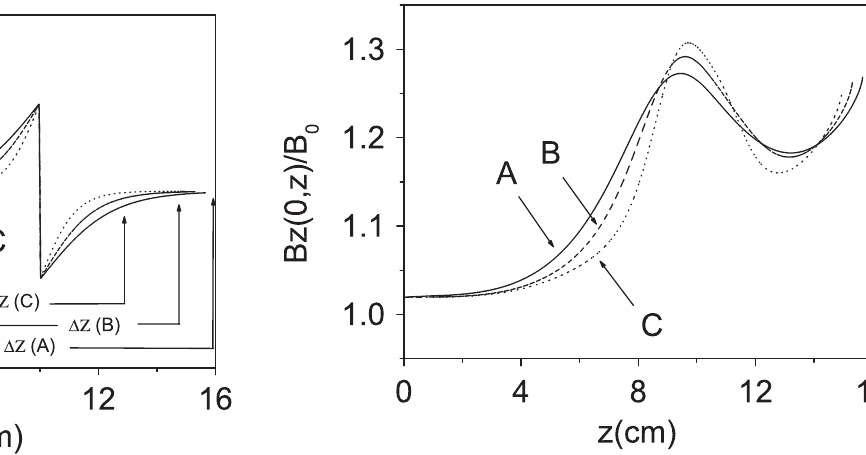
.FIG. 9. Dependence of the phase shift on the longitudinal coordinate for different lengths (cid:2) z of the zone where the phase shift varies: (A) (cid:2) z ¼ 12 cm , (B) (cid:2) z ¼ 9 cm , (C) (cid:2) z ¼ 6 cm . FIG. 10. Electron energy space evolution for different lengths of the zone where the phase shift is varied: (A) (cid:2) z ¼ 12 cm , (B) (cid:2) z ¼ 9 cm , (C) (cid:2) z ¼ 6 cm .